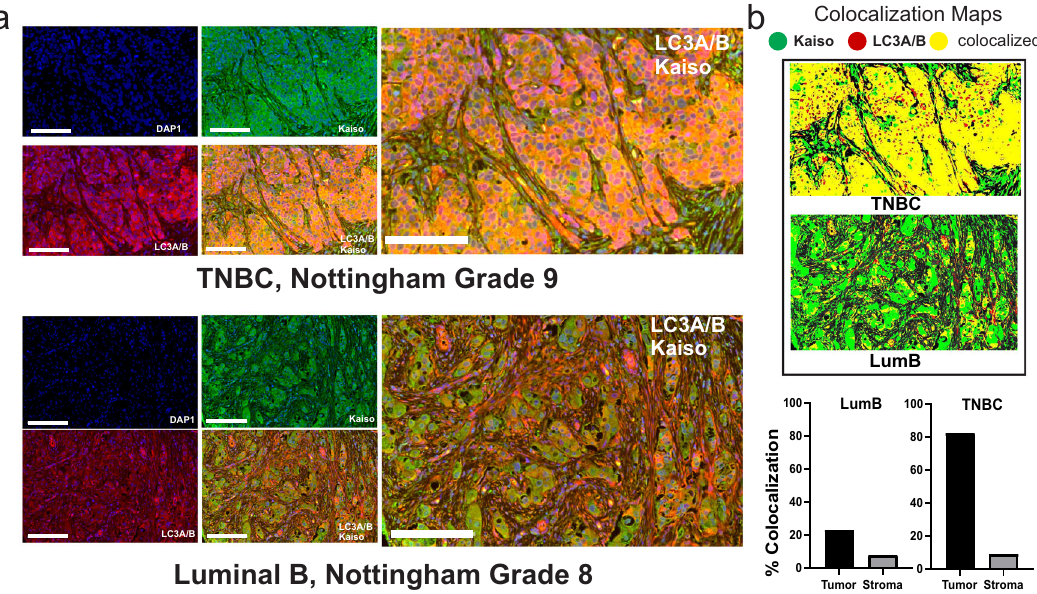
Fig. 5 Kaiso and LC3A/B show extensive colocalization in both the nucleus and cytoplasm of patient tumors. a Immuno fl uorescent staining of Kaiso (green) and LC3A/B (red) in TNBC breast cancer (upper panel) and Luminal B breast cancer (lower panel). b Colocalization maps showing relative colocalization of Kaiso and LC3A/B in patient